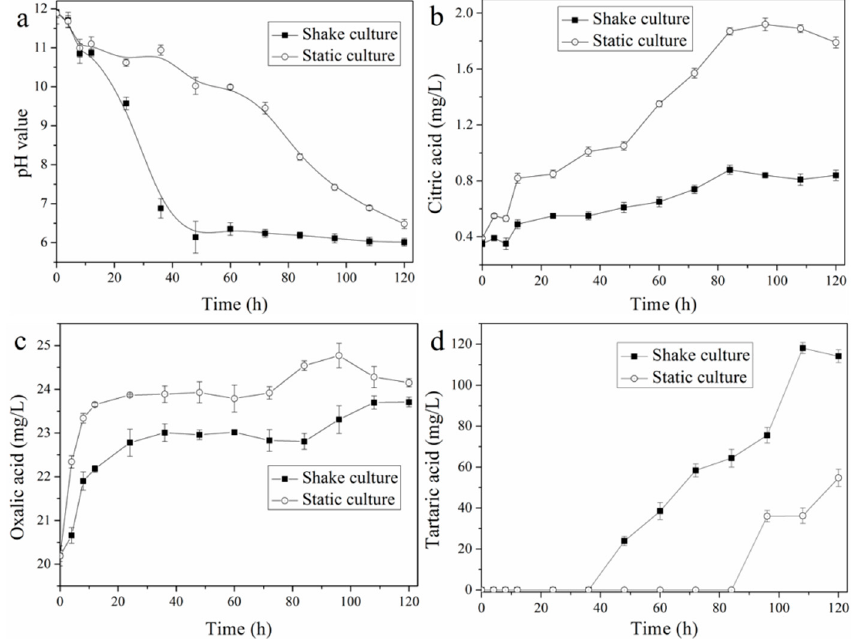
Figure 2. Change in pH value and production of organic acid by ZH-1 in optimal medium under both agitated and static conditions. ( a ) Change in pH; ( b ) production of citric acid; ( c ) production of oxalic acid; ( d ) production of tartaric acid.